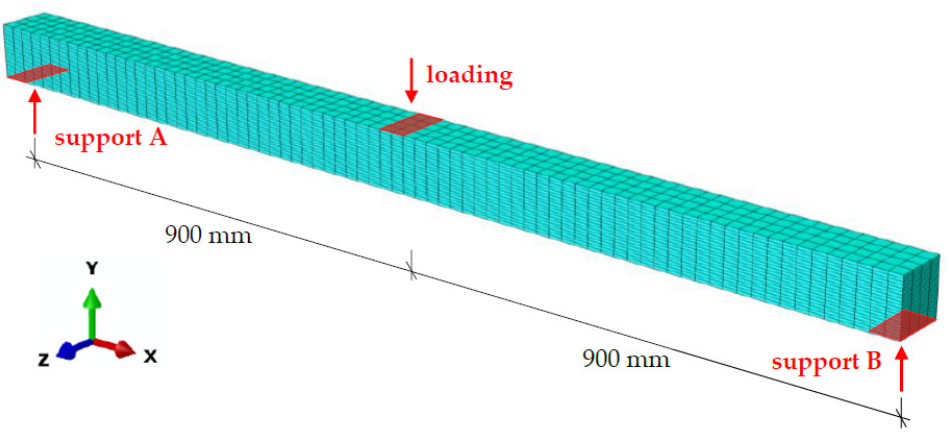
Figure 6. FE solid model of a bending test with span 1800 mm including support and loading areas.